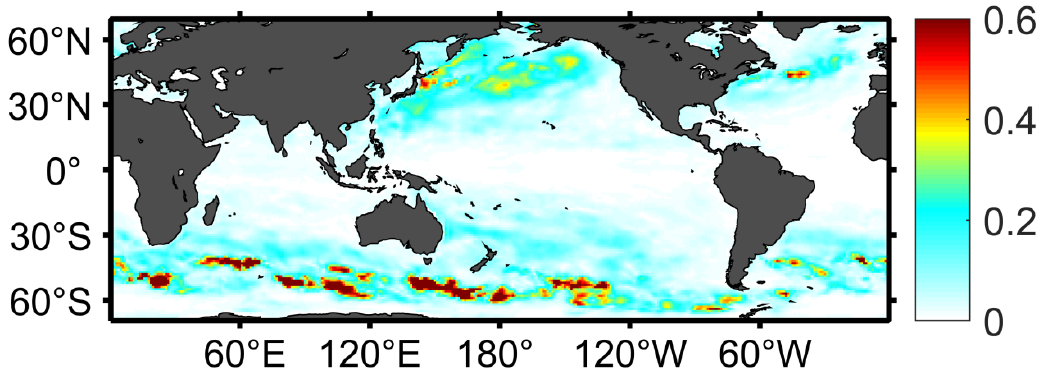
Figure 11 . Horizontal distribution of spread of covariance between SSH and SST during running CESM-EAKF.